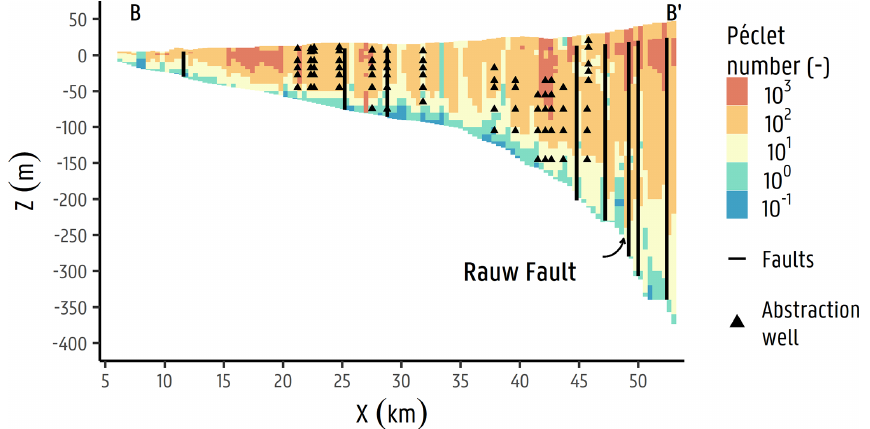
Figure A6. Péclet numbers ( Pe ) derived from groundwater model results presented by Casillas-Trasvina et al. (2021). Note the considerably lower values ( Pe ≤ 1) in the deepest parts of the Neogene Aquifer corresponding to the Berchem and Voort sands.